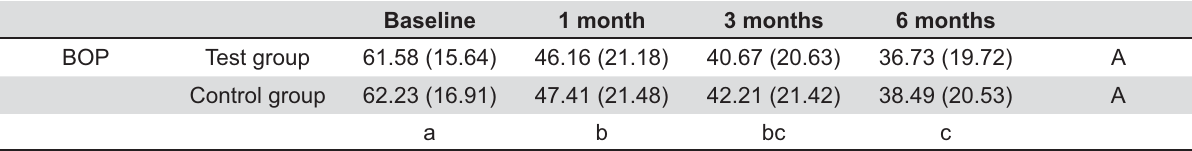
Table 2- Mean (standard deviation) of bleeding on probing (BOP) at different time intervals for both groups